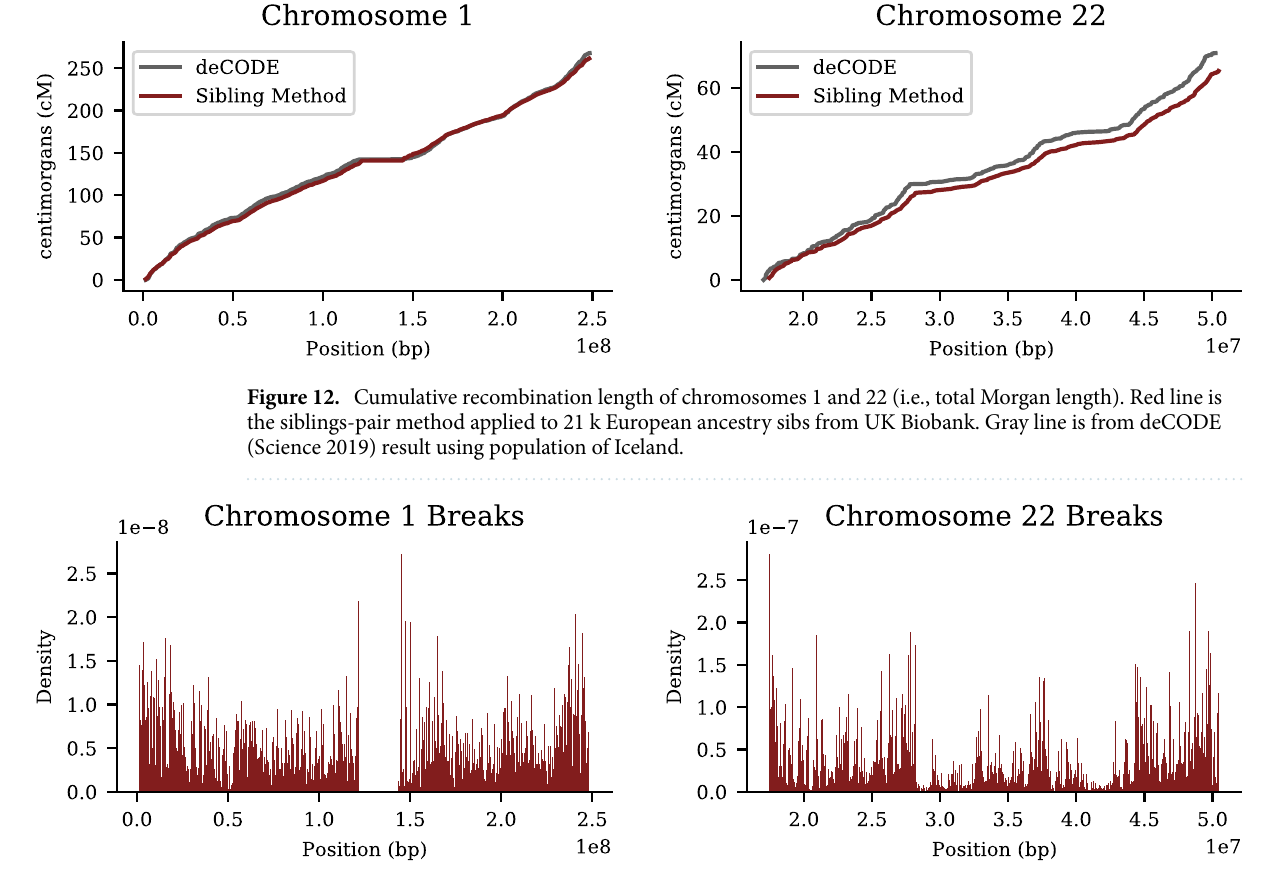
Figure 13. Density of recombination breaks on chromosomes 1 and 22 from sibling-pair method, computed using 21 k European sibling